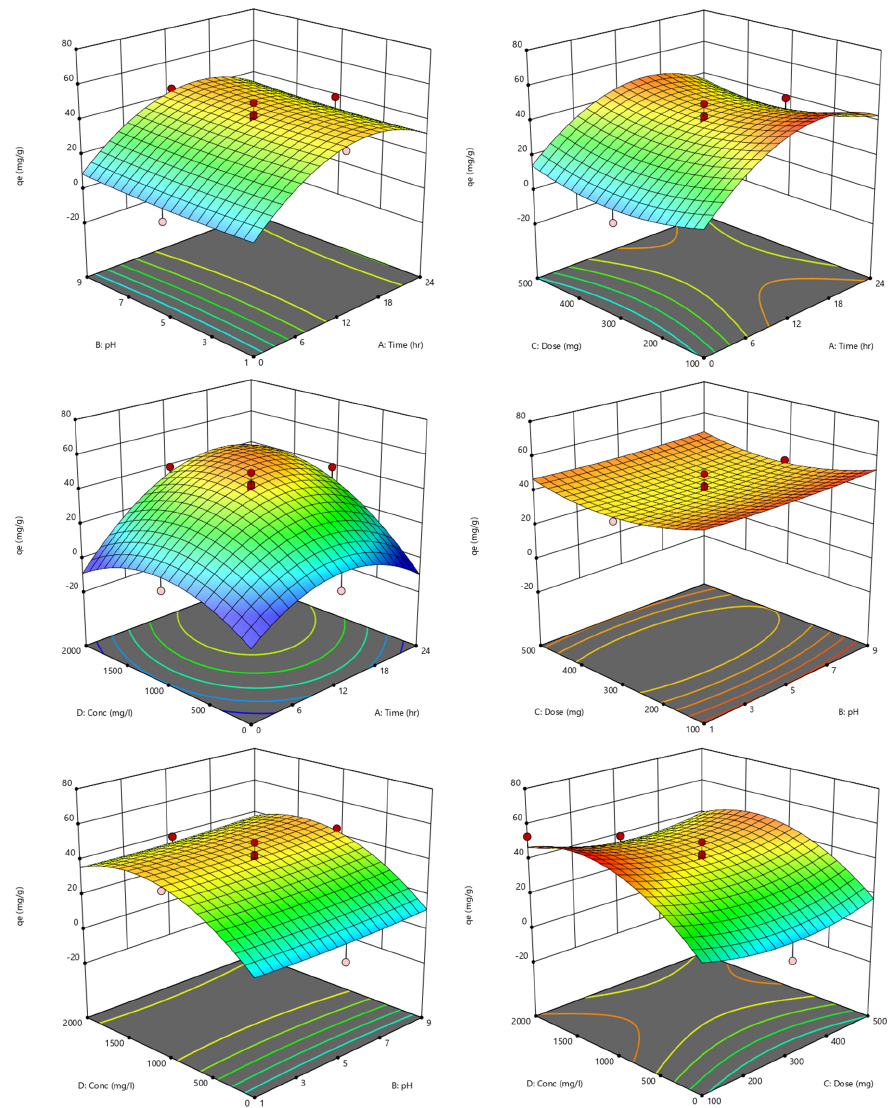
Figure 13. The 3D dimension images of Cu(II) removal efficiency onto H + Dowex-M4195 chelating resin from the selected quadratic model related to the pH, Time, Dose, Conc. and q e.